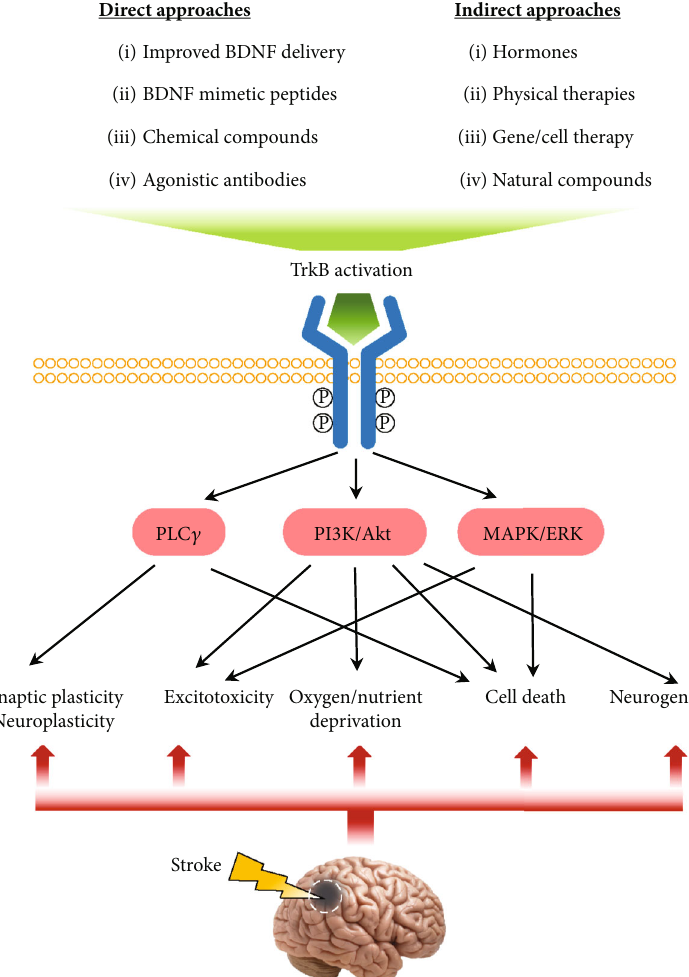
Figure 4: Summary of approaches to enhance TrkB activation and their e ff ect on stroke treatment and recovery. Multiple strategies could be utilized to activate the TrkB receptor to serve in the treatment and recovery of stroke comorbidities. Direct approaches include the modi fi cation and improvement of BDNF for better delivery and the development of BDNF mimetic peptides, small molecule compounds, and speci fi c agonistic antibodies. Indirect approaches include hormones, physical therapies, and natural compounds that can stimulate the endogenous expression of BDNF and gene/cell therapy to overexpress BDNF. TrkB receptor activation directly triggers and stimulates downstream signaling cascades, which subsequently protect neuronal cells and facilitate poststroke brain recovery. While the PLC γ pathway has been suggested to play a role in neuroplasticity and in cell death, the PI3K/Akt and MAPK/ERK pathways mainly protect neurons from excitotoxicity and cell death, chie fl y apoptosis. The PI3K/Akt signaling is also reported to support neuronal survival under oxygen/nutrient deprivation and to contribute to neurogenesis during